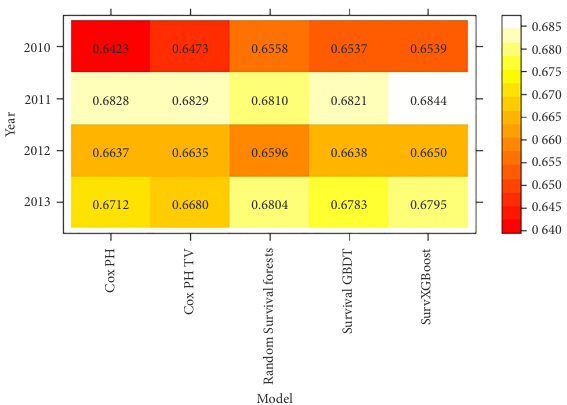
Figure 3. Out-of-time validation results of AUC